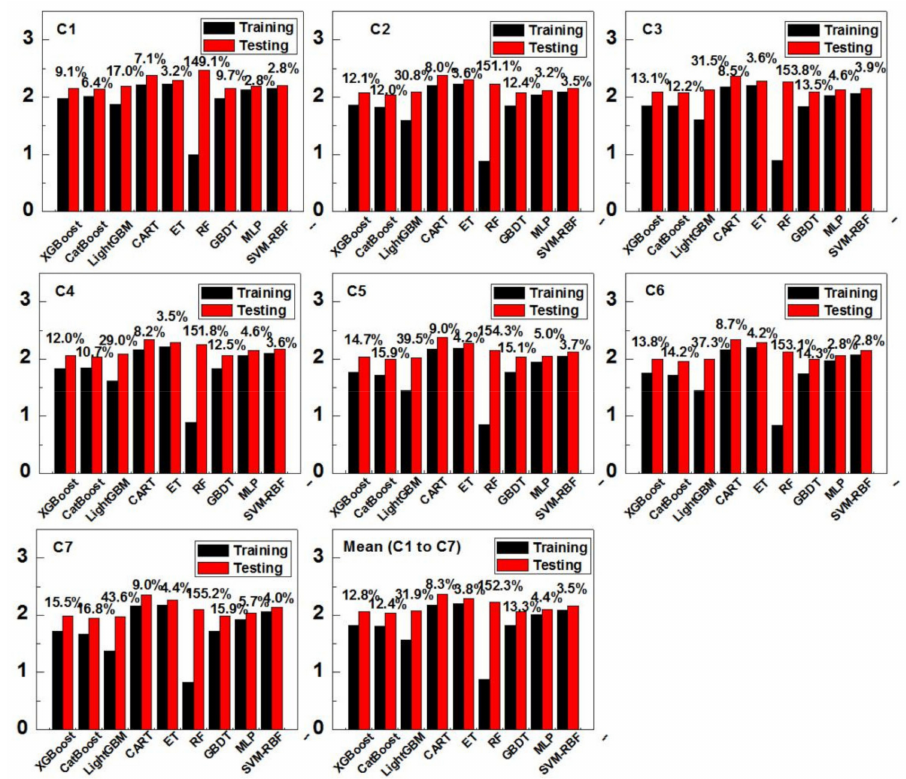
Figure 7. Percentage increase in testing RMSE over training RMSE (average over the sixteen stations) for the various machine learning models under different input